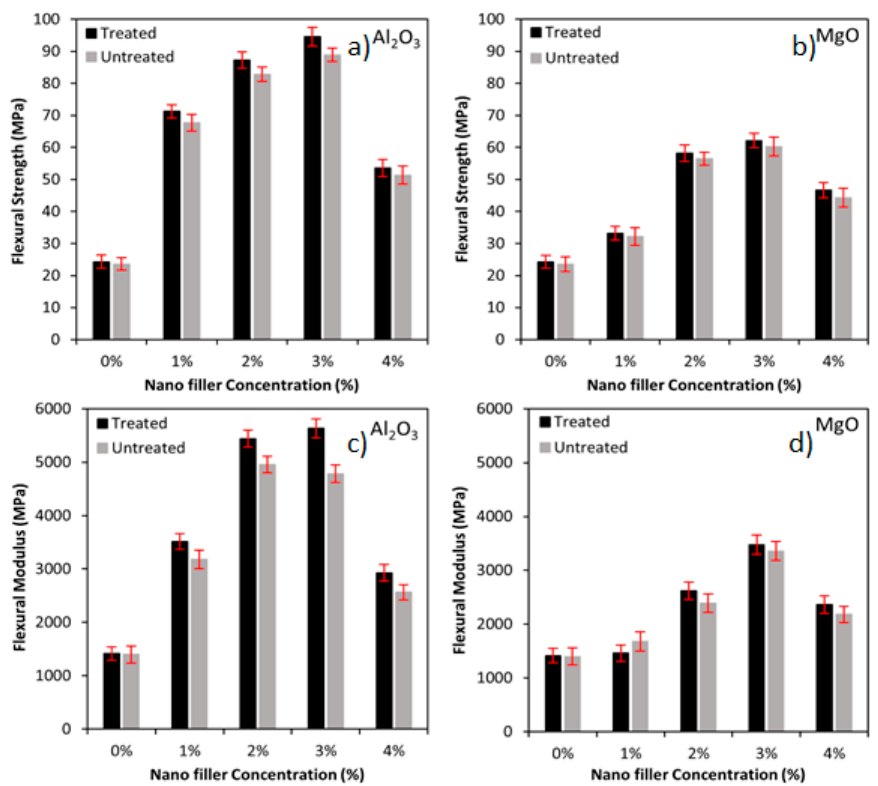
Figure 3. ( a ) Flexural strength of nano Al 2 O 3 , ( b ) Flexural strength of MgO, ( c ) Flexural modulus of nano Al 2 O 3 , ( d ) Flexural modulus of MgO incorporated flax/PLA epoxy hybrid composites.